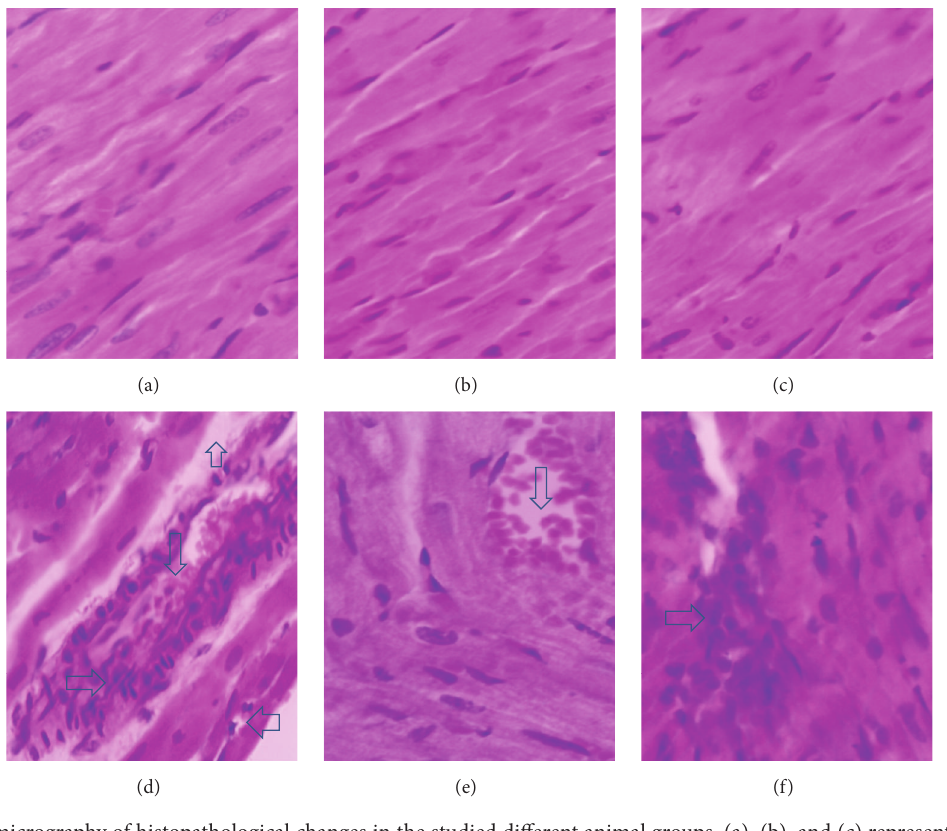
Figure 1: Photomicrography of histopathological changes in the studied different animal groups. (a), (b), and (c) represent normal cardiac tissue sections from the control, metformin, and sitagliptin groups, respectively. (d) shows extensive myocardial degeneration (up arrow), perinuclear vacuolization (left arrow), inflammatory cells (right arrow), and interstitial hemorrhage (down arrow) found in the DOX group. (e) and (f) show significant improvement in the pathological features in the metformin/DOX and sitagliptin/DOX groups, respectively, as compared to (d). Sections were stained with H&E and magnification used was